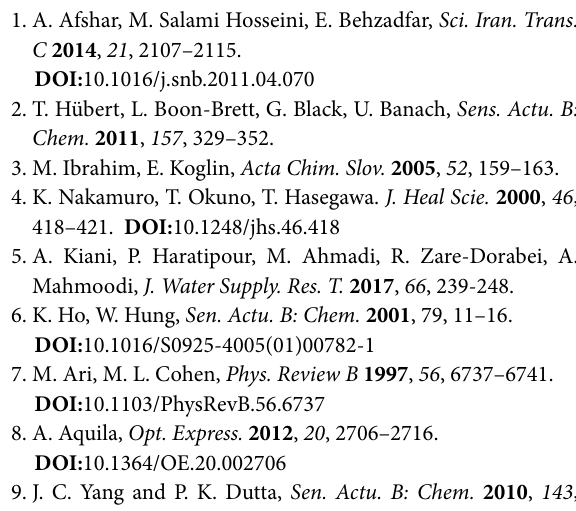
Table 1. Calculated E AlN-NCS and Cl-AlP-NCS surfaces. G (kJ/mol) E ad